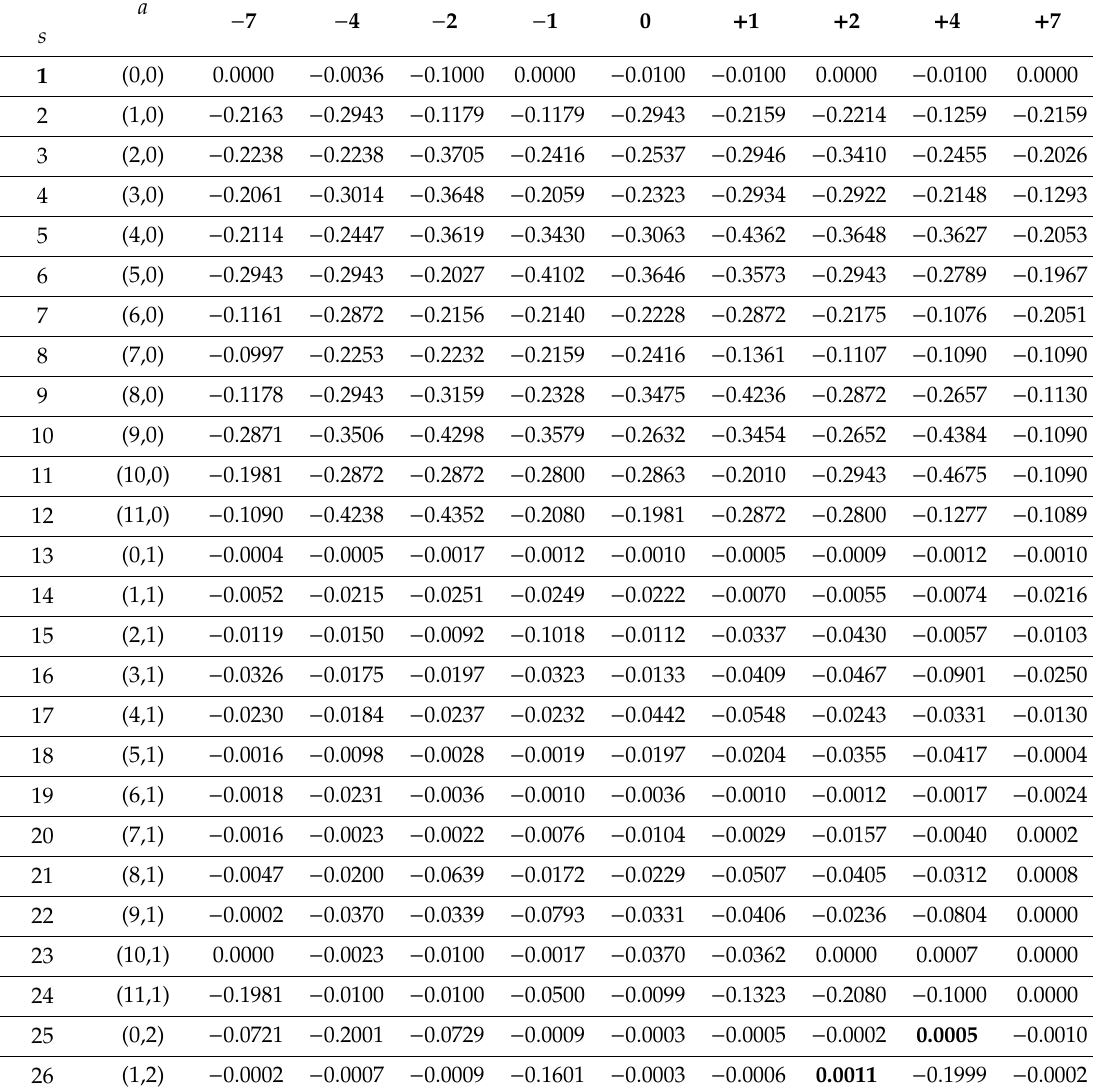
Table 7. Final Q-table of the straightforward gait